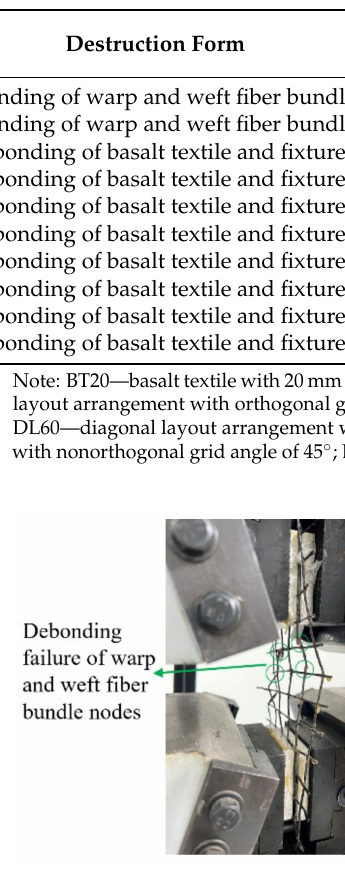
Table 3. Mechanical properties of epoxy-impregnated textile.